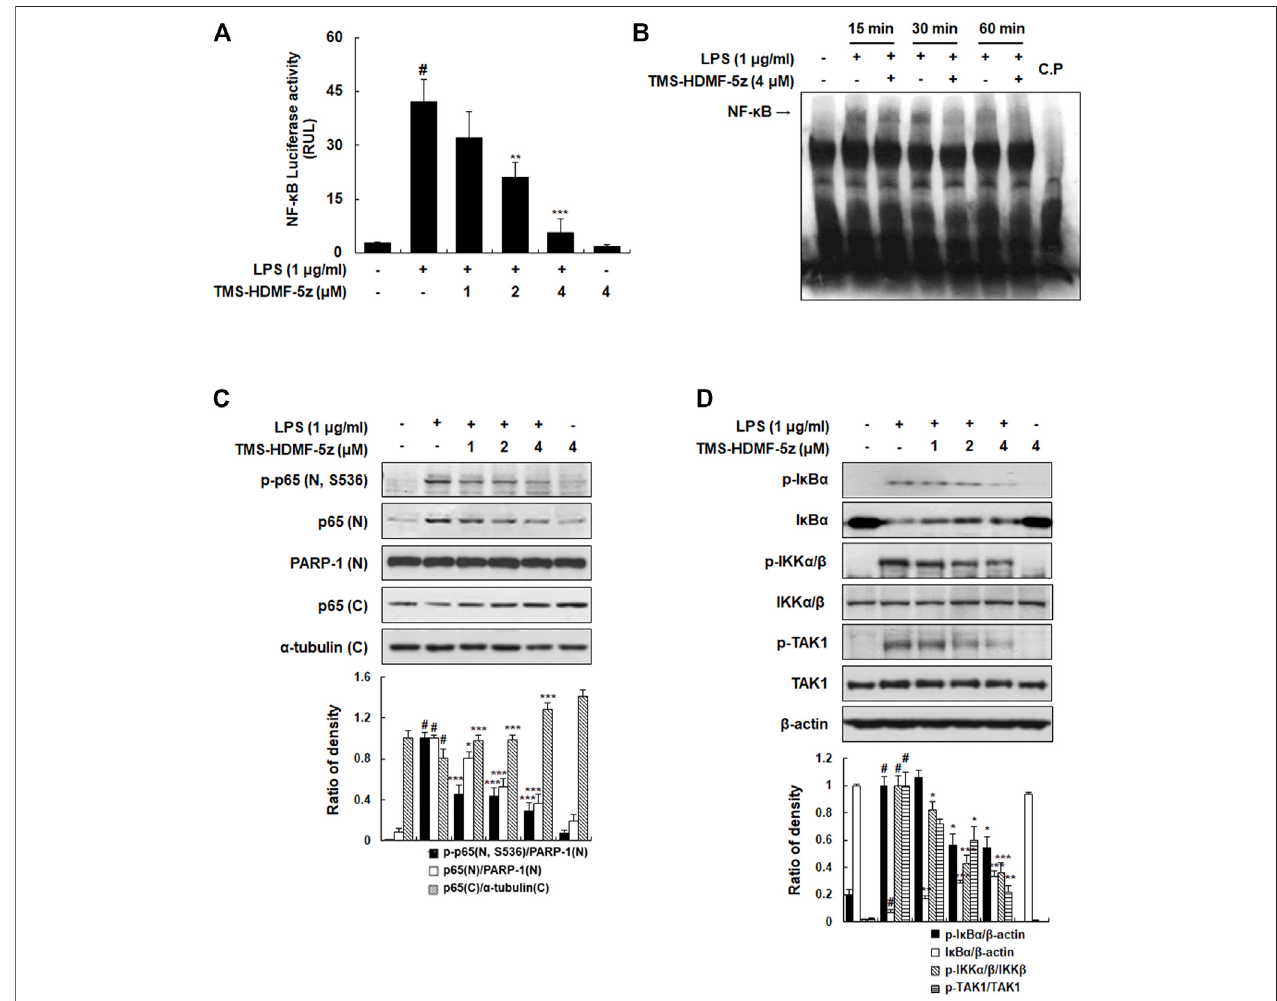
FIGURE2| InhibitoryeffectsofTMS-HDMF-5zonLPS-stimulatedNF- κ BactivityandphosphorylationofI κ B α ,IKK,andTAK1inRAW264.7macrophages. (A) NF- κ Bluciferase activity inwhole-cell extracts wasestimated usingthe PromegaLuciferaseAssaySystem (Promega Corp., WI, United States). (B) TheDNAbindingactivity of NF- κ B was determined using EMSA. (C) The nuclear and cytosolic p-p65 (S536) and p65 proteins were detected using western blotting. The relative optical density ratio vs . Poly (ADP-ribose) polymerase-1 (PARP-1) or α -tubulin was determined using a densitometric analysis program (Bio-Rad Quantity One Software, version 4.6.3 (Basic), Bio-Rad Laboratories Inc., CA, United States), normalized to the internal control. (D) The protein expression of p-I κ B α , I κ B α , p-IKK α / β , IKK β , p-TAK1, and TAK1 was detected by western blotting. The relative optical density ratio vs . ß -actin or total form was determined using a densitometric analysis program (Bio-Rad Quantity One Software, version 4.6.3 (Basic), Bio-Rad Laboratories Inc., CA, United States), normalized to the internal control. Data are shown as the mean ± S.D. of three independent experiments. # p < 0.05 vs . the control group, *p < 0.05, **p < 0.01, ***p < 0.001 vs . LPS-treated